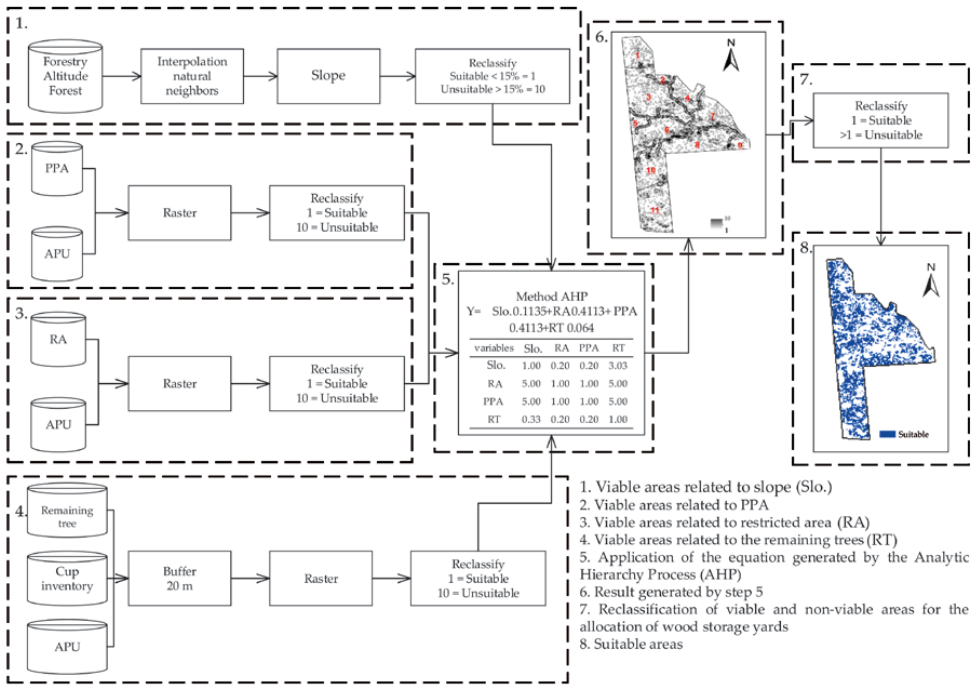
Figure 2. Scheme of obtaining data and methodology for the definition of areas suitable for the allocation of wood storage